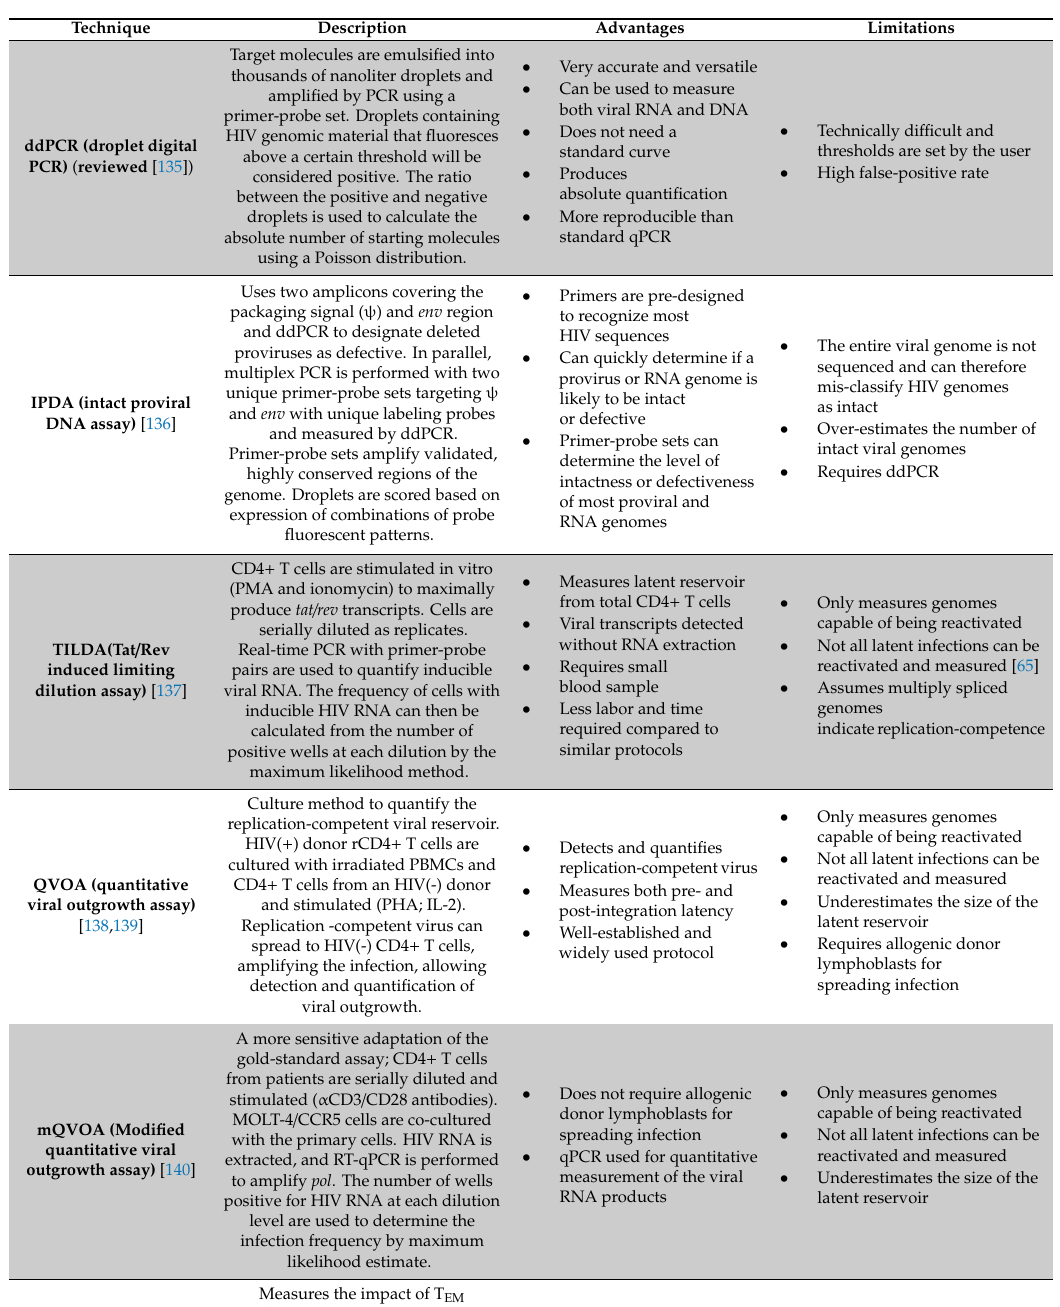
Table 4. Measuring the Latent